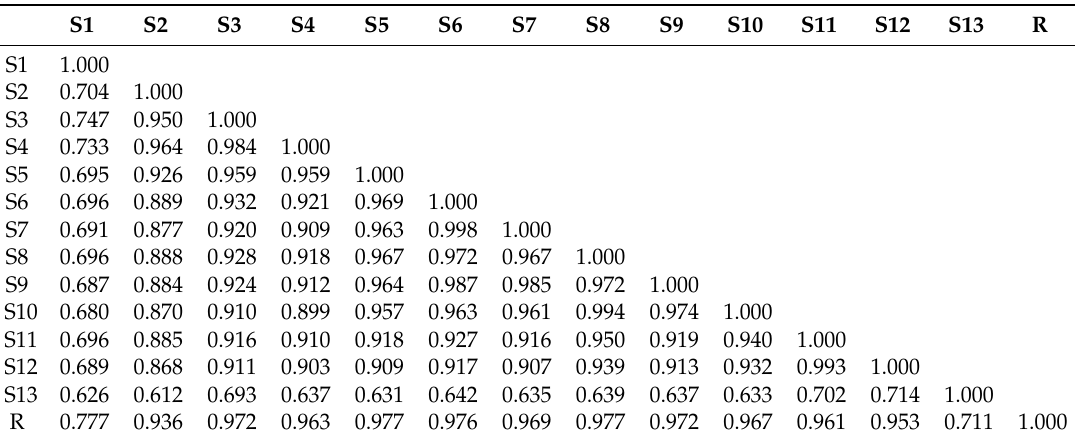
Table 2. Similarities among collagen peptides from 13